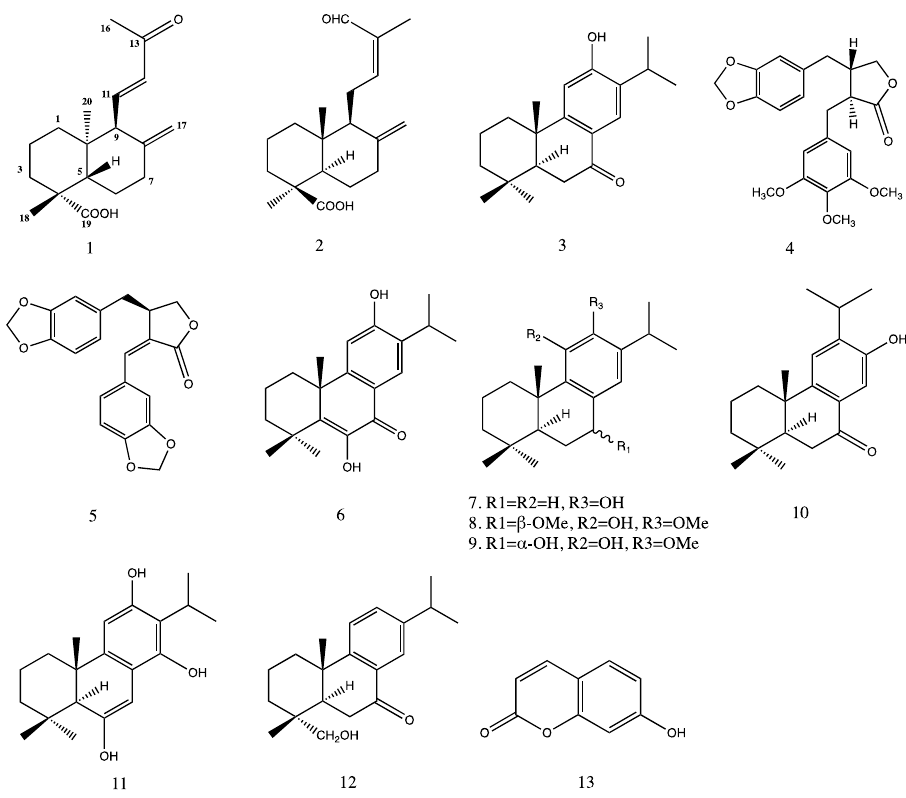
Figure 1. Structures of compounds 1 – 13 .